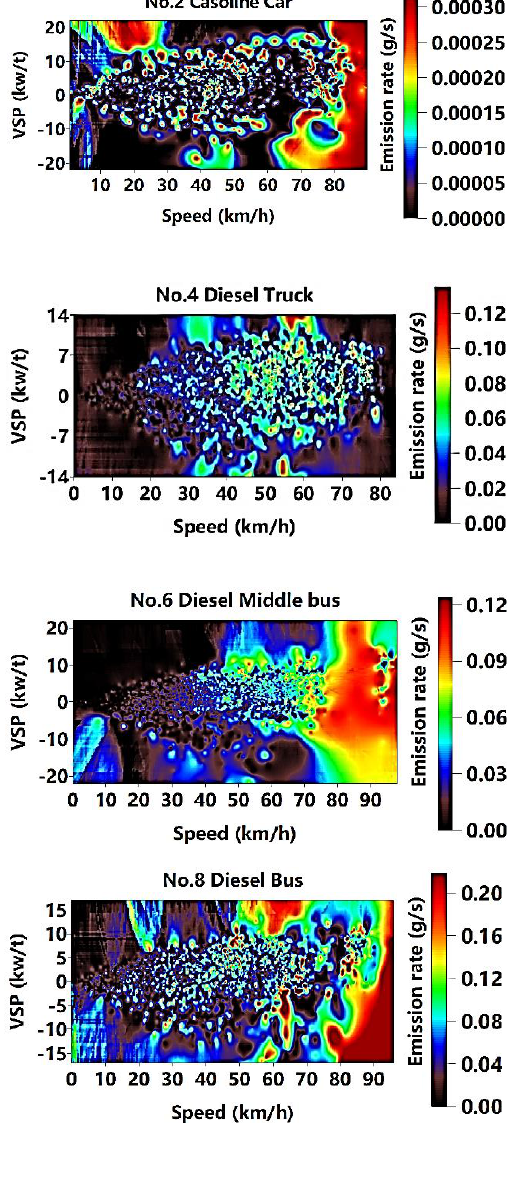
Figure 3. The image maps of the relationship between speed-VSP and HC emission rates. HC emission rates are represented by the colors. The black, brown, blue, cyan, green, yellow, orange, red, and ruby red areas indicate that the emission rates are approximately 0, 0.5, 1, 1.5, 2, 2.5, 3, 3.5, and over 4 times the average emission rate, respectively. Speed is at the X-axis, and VSP is at the Y-axis.